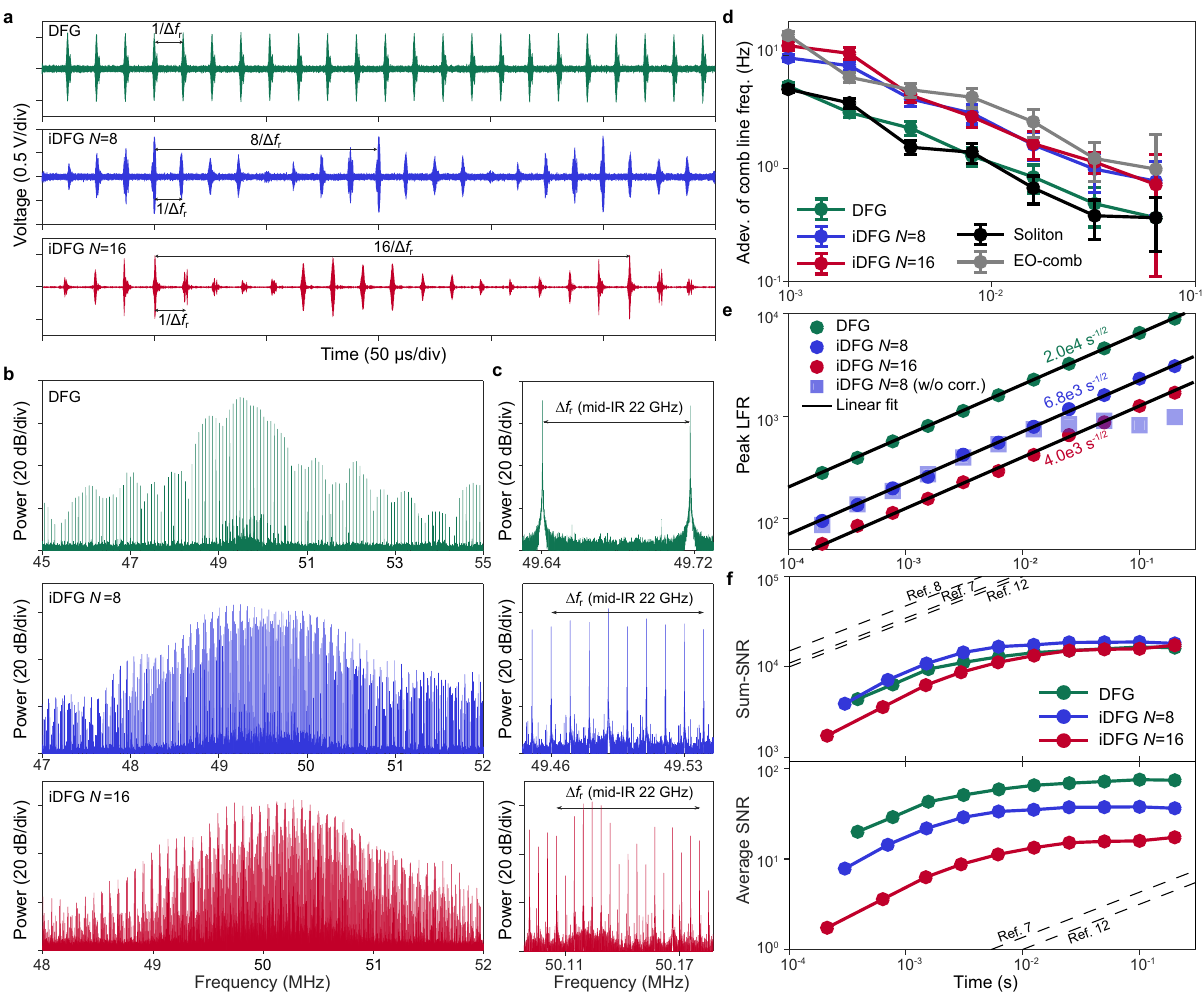
Fig. 2 Interferograms and multi-heterodyne spectra of the iDFG densi fi ed mid-IR combs. a Interferogram of the mid-IR combs using DFG and iDFG. The interferograms for the iDFG combs repeat at a rate of Δ f r / N . b Dual-comb spectra formed by fast Fourier transform of the measured interferograms. The radio frequency combs are spectrally densi fi ed when using iDFG. c Zoom-in of the radio-frequency combs in panel ( b ). A 22 GHz scale giving the corresponding optical bandwidth in the mid-IR is provided. d Allan deviation of the frequency of a single line measured at the centre of the multi- heterodyne spectra plotted versus the measurement time. The generation mechanism is indicated in the legend. The error bar corresponds to the standard deviation of the Allan deviation. e Plot of the LFR versus measurement time τ for strongest spectral line using conventional and interleaved DFG. The solid ffiffiffi p τ lines are linear fi ts ( trend in the log − log plot). All circular points are digitally corrected. Squares points show the uncorrected results for N = 8. f Plot of the sum- and average SNR of our mid-IR DCS system versus the measurement time τ . Black dashed lines are SNR for reported mid-IR DCS pulses exhibit different envelope modulation for the iDFG N = 8 and N = 16 cases.